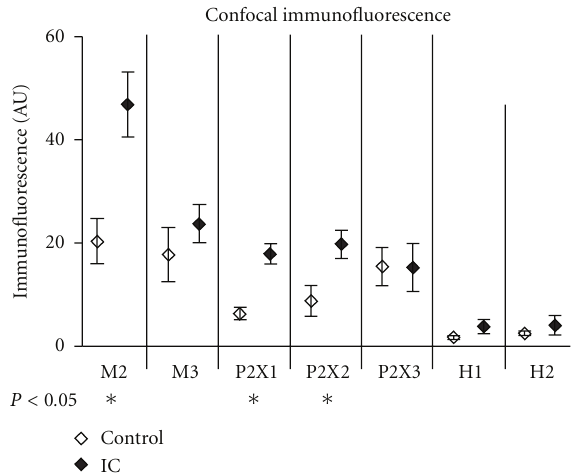
Figure 4: Comparison of the receptor expression in detrusor biopsies from age-matched patient collectives (control n = 9; BPS/IC n = 19). P values < 0.05 were considered significant (Mann-Whitney nonparametric statistical test).